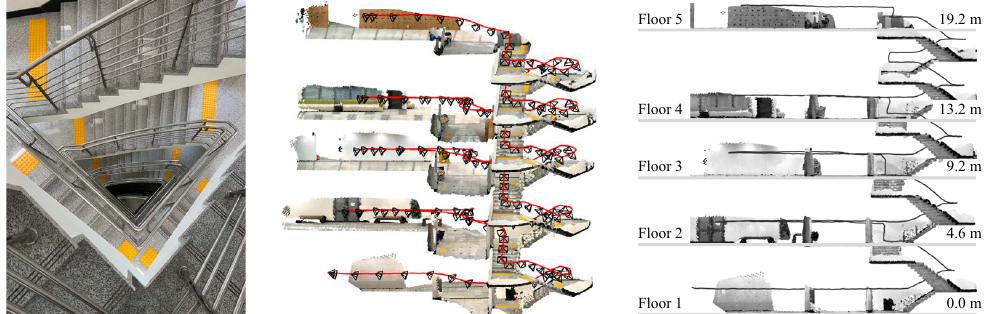
Figure 2. Accumulated 3D point cloud ( middle ) with the estimated 6-DoF trajectory (red) from Apple ARKit in multi-floor environments. We captured the 6-DoF camera poses and 3D points while climbing the multi-story stairs ( left ). Among the four proprietary VIO systems, Apple ARKit showed the most consistent and accurate 6-DoF motion-tracking results, as it consistently reconstructed the 3D geometry of stairs and hallways. The track (red) and 3D reconstruction results of Apple ARKit had a similar shape to that of the ground-truth blueprint of the building ( right